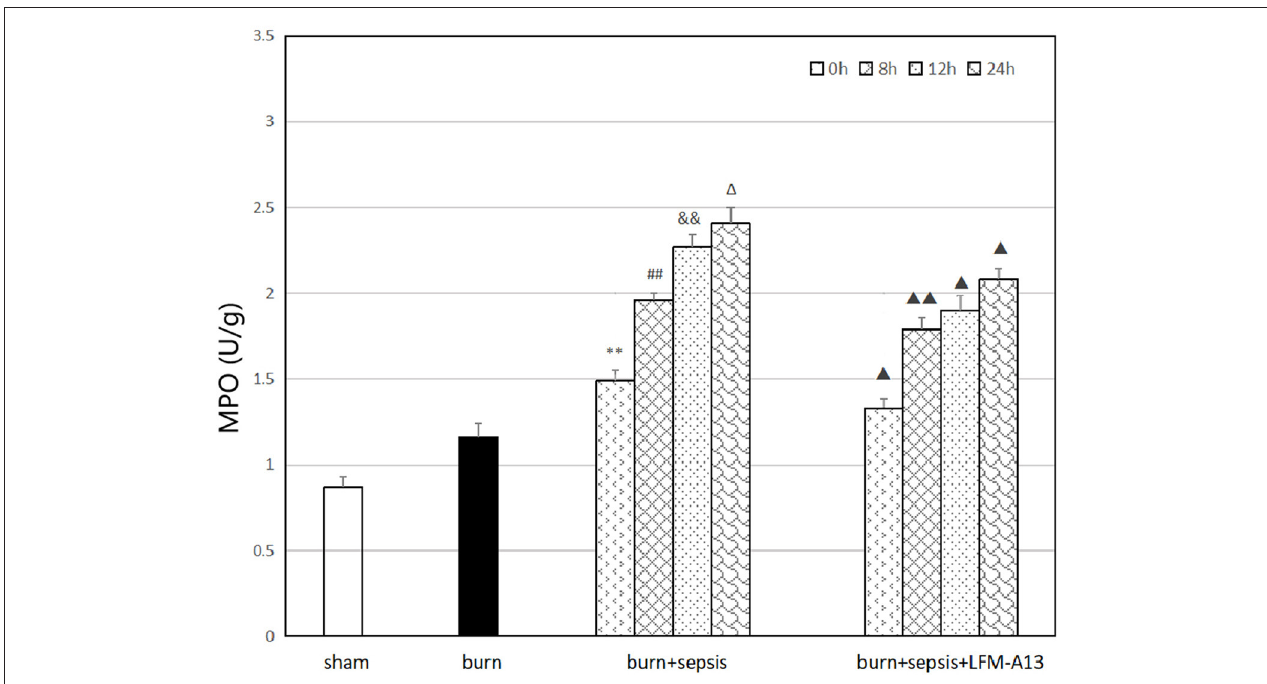
FIGURE 5 | Activity of MPO in intestinal tissue at different time points in each group. ** P < 0.01, vs. the sham group and burn group; in the burn + sepsis group, ## P < 0.01, vs. 0h, && P < 0.01, vs. 8h, 1 P > 0.05, vs. 12h; N P < 0.05, NN P < 0.01, vs. the burn + sepsis group at corresponding time points.